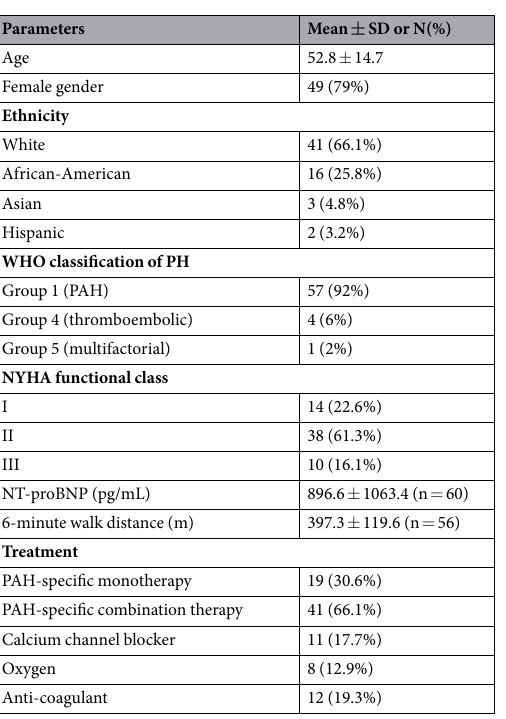
Table 1. Demographic characteristics (n = 62). Data is presented as mean ± standard deviation or number (%). PH = pulmonary hypertension; PAH = pulmonary arterial